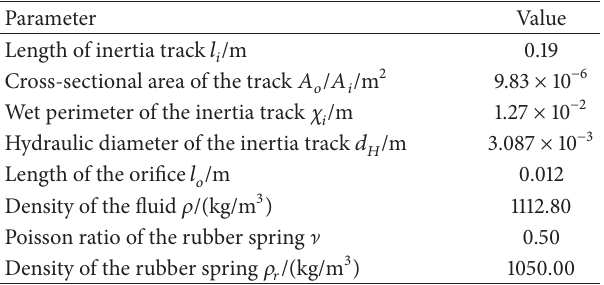
Table 1: Geometric and material parameters of a typical